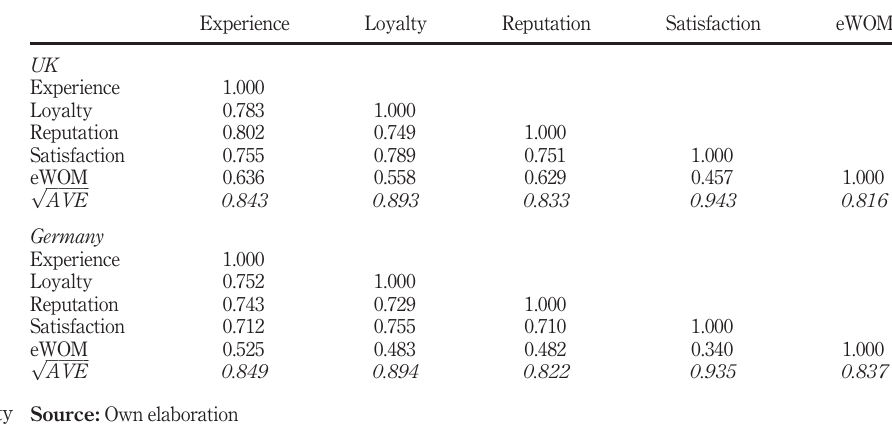
Table III. Discriminant